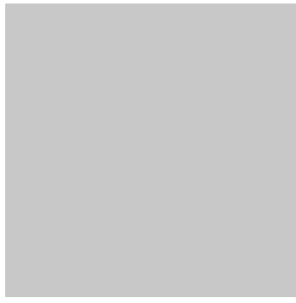
Figure 10. Original image, 16 × 16 grey BMP.